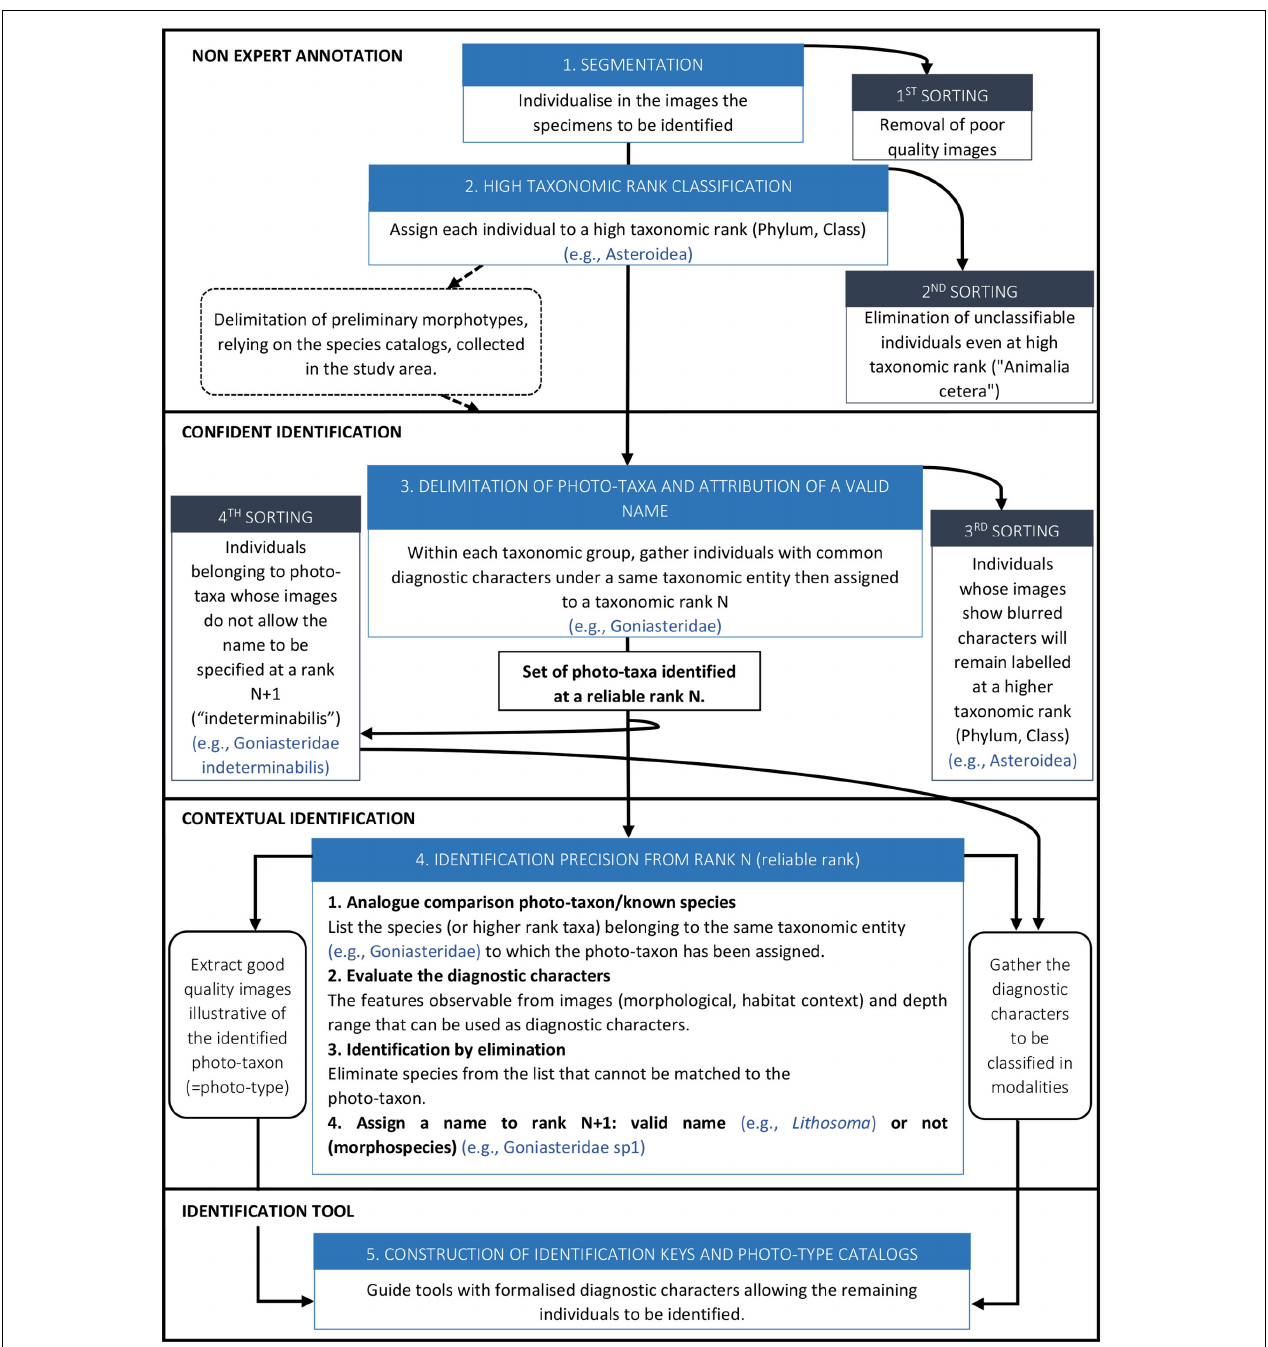
FIGURE 3 | Flowchart of faunal identification steps from images. Five steps – from image annotation to construction of identification keys – divided into three main processes that involve different levels of expertise: non-expert annotation, confident identification and contextual identification.